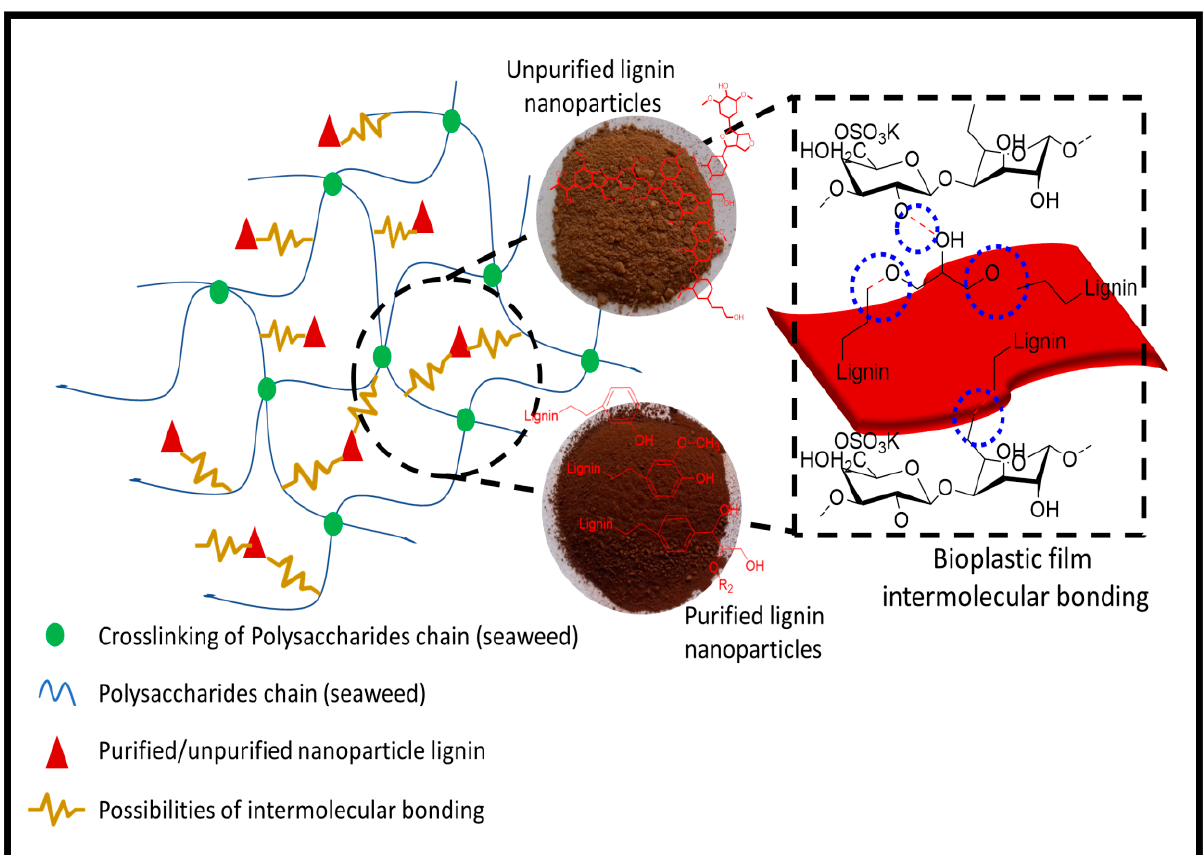
Figure 6. Proposed intermolecular bonding mechanism of Kappaphycus alvarezii bioplastic films functioned with LNPs.